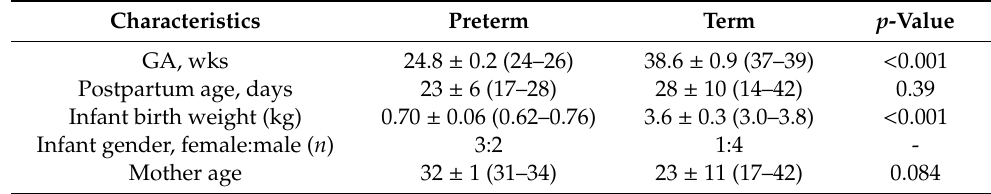
Table 1. Characteristics of preterm- and term-delivering mothers for milk collection 1